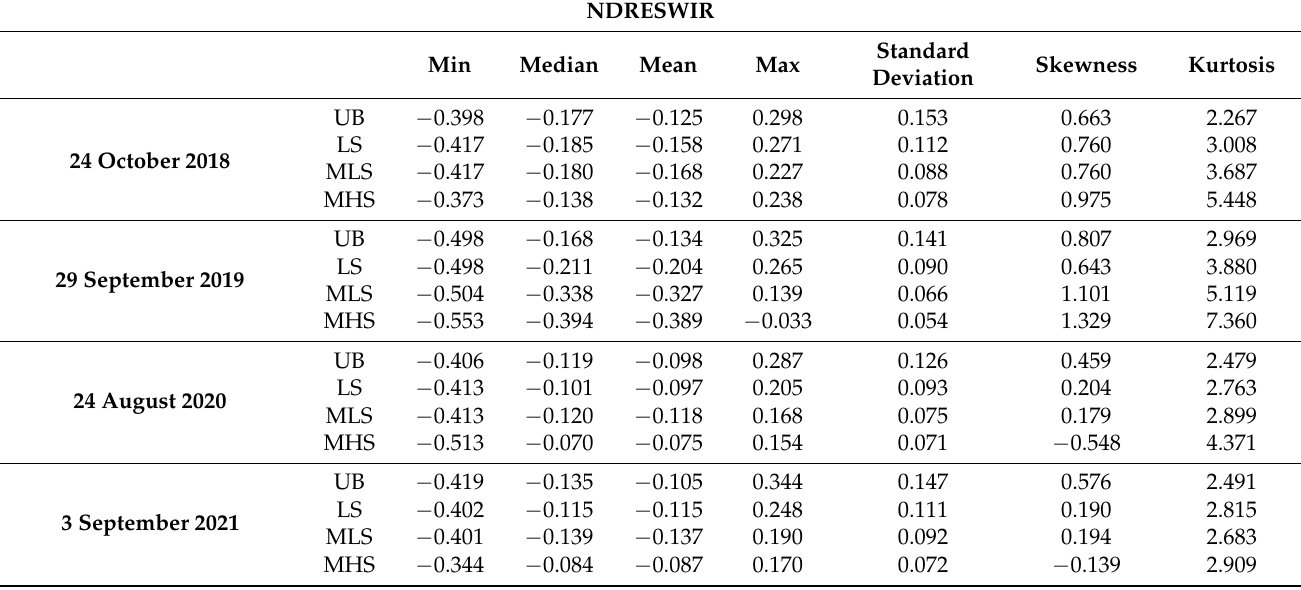
Table A3. Statistics of pre- and post-fire NDRESWIR in different fire severity classes at the El Saco basin. NDRESWIR Standard Min Median Mean Max Deviation